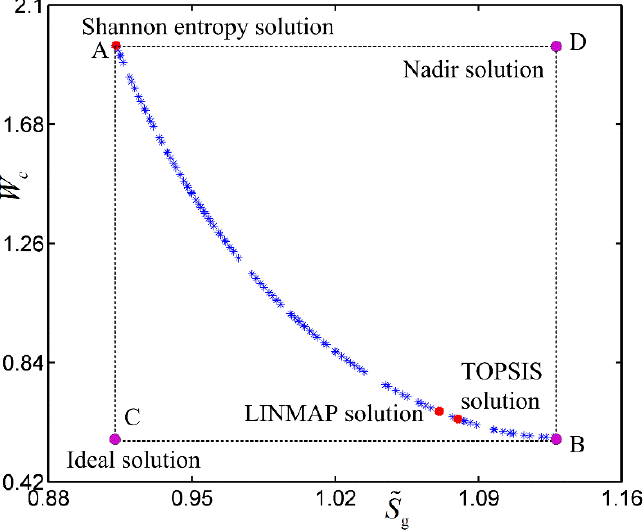
Figure 13. Pareto optimal front of (cid:101) S g and (cid:101) W c gained by multi-objective optimization. Figure 11. Pareto optimal front of the Table 1. Optimization results gained by single and multi-objective optimization. From Fig. 11, the Pareto optimal set locates between the ideal solution (point 266 C) and nadir solution (point D), which is the compromise between the EGR and TPP under 267